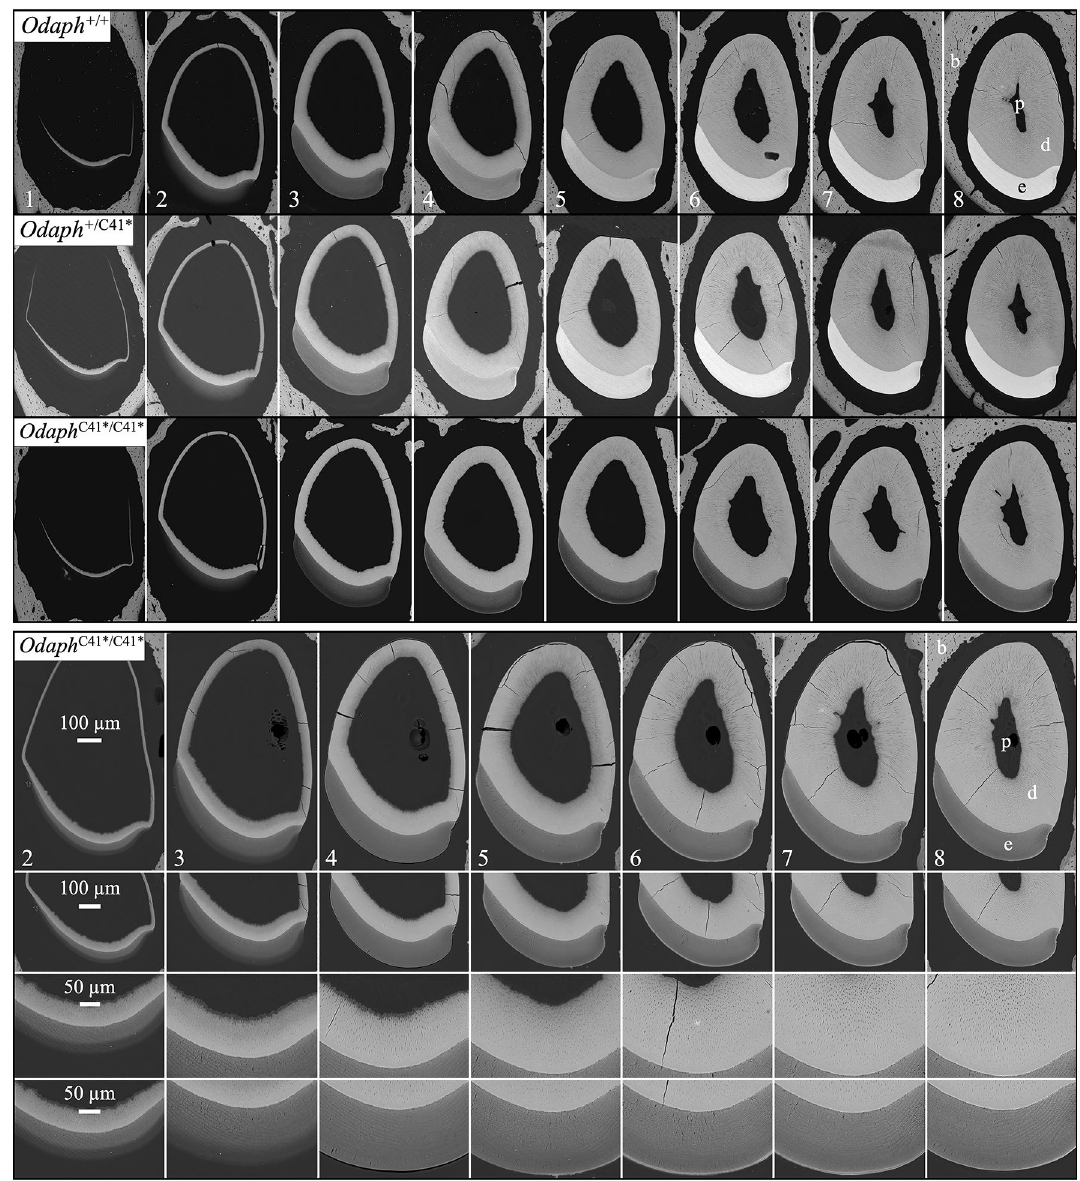
Figure 6. bSEM of 7-wk Odaph +/+ , Odaph +/C41* , and Odaph C41*/C41* Mouse Mandibular Incisor Cross-Sections. These panels show 1-mm (basal, left; incisal, right) incremental cross-sections of 7-wk mandibular incisors taken from Odaph +/+ , Odaph +/C41* , and Odaph C41*/C41* mice. Top: Comparison of the 3 genotypes from levels 1 to 8 showed that the early progress of dentin and enamel deposition is similar in all three genotypes, with the enamel layer having achieved its final contour and thickness by level 3. After level 3 the striking finding was the failure of the Odaph C41*/C41* enamel layer to increase in density, as occurred in the Odaph +/+ and Odaph +/C41* incisors. Bottom: High magnification views of Odaph C41*/C41* sections showed normal dentin and dentin tubules and enamel rod decussation patterns and final enamel thickness. The only deficiency was the dramatic lack of enamel maturation in the Odaph C41*/C41* incisors. The Odaph C41*/C41* enamel surface was the only part of the enamel layer that increased in density. Key: b: bone, p: pulp, d: dentin, e: